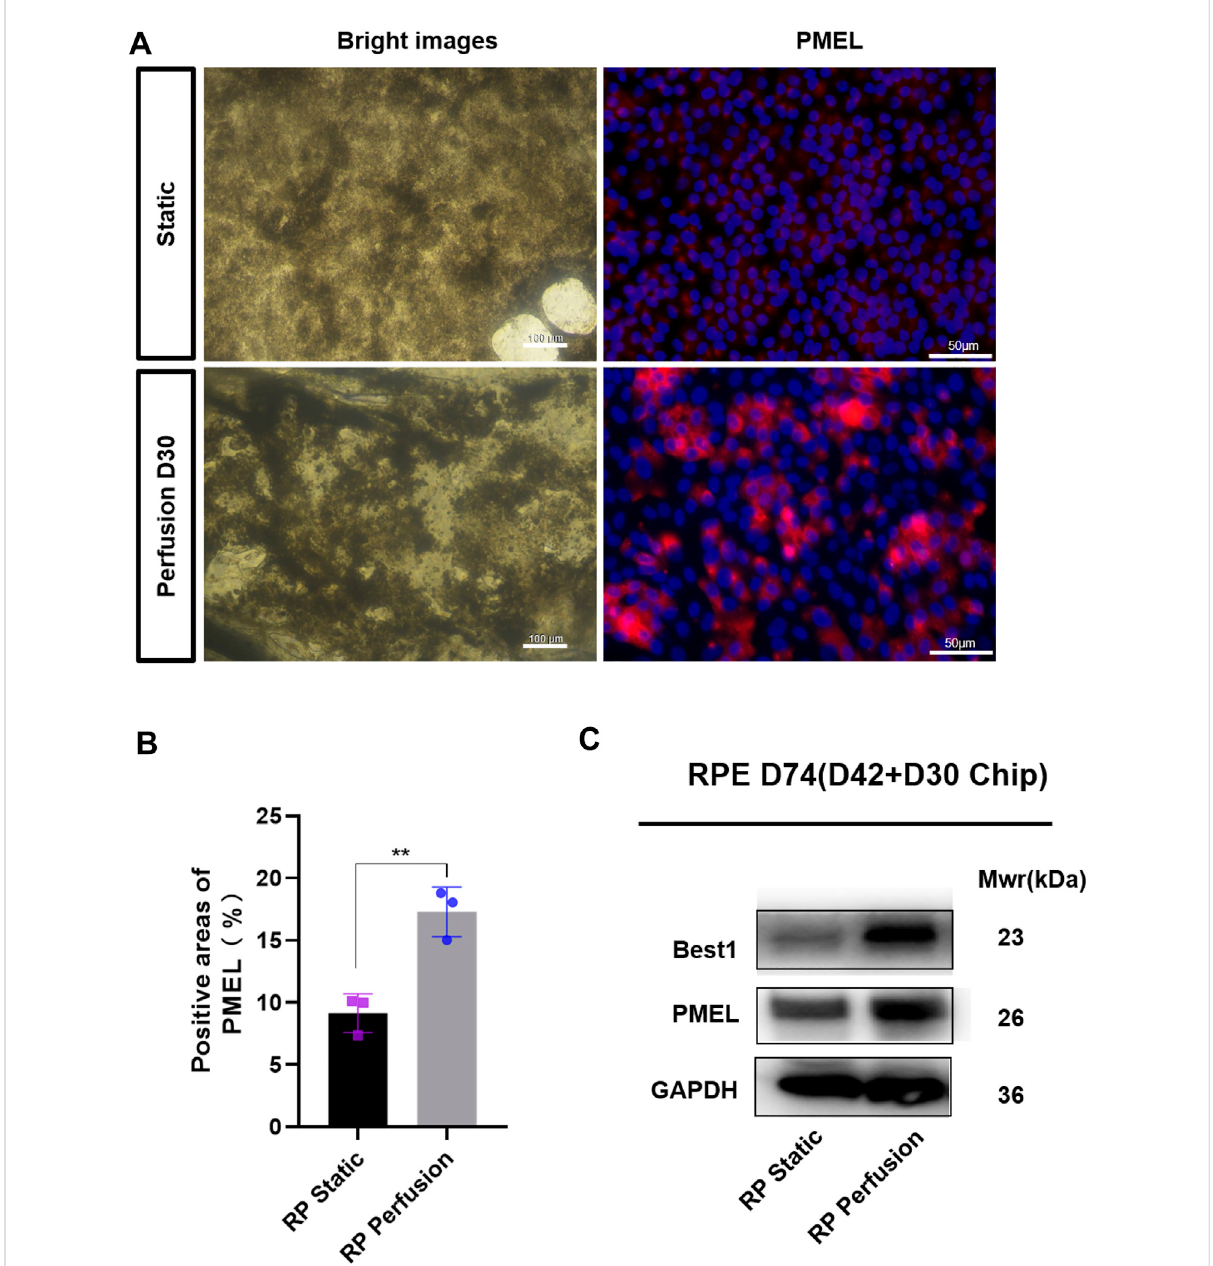
FIGURE 7 Quantitative comparison of RPE cells in two culture methods. (A) Bright images of RPE cells under two culture conditions and immunostaining images of PMEL (red). (B) Positive areas analysis. Data are shown as mean ± SD. ** p < 0.01 ( n = 3) (C) Perfused culture of RPE cells leads to an upregulation of BEST1 and PMEL. Scale bar:50 μ